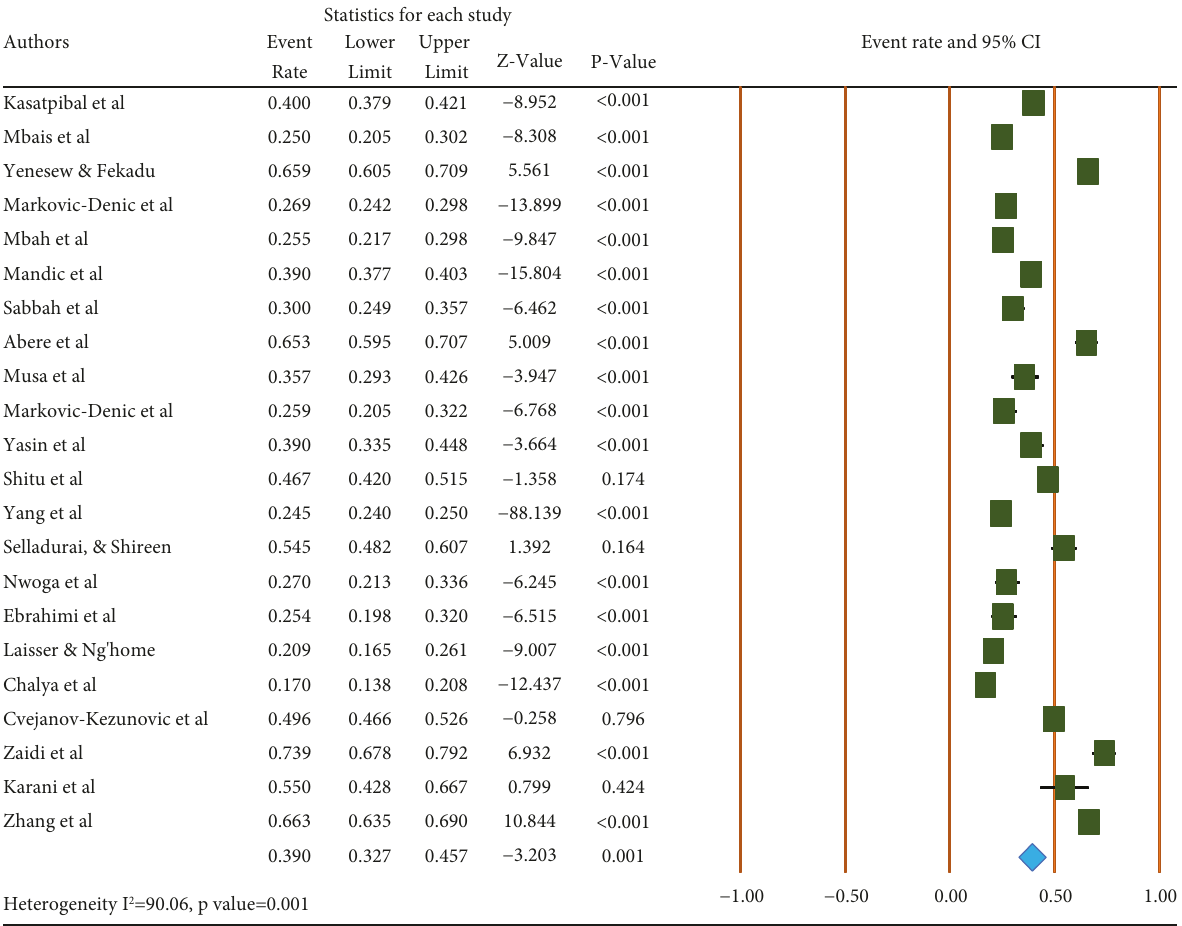
Figure 2: Pooled prevalence of occupational exposure to blood and body fluids in the last 12 months among healthcare